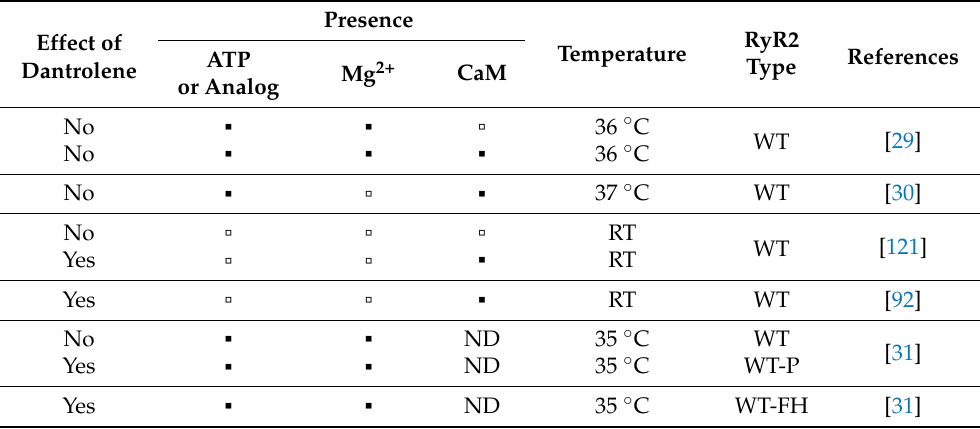
Table 1. Effect of dantrolene on the RyR1 channel in cell-free experiments. ATP, Mg 2+ , CaM, and dantrolene were added to the RyR1 cytosolic face.